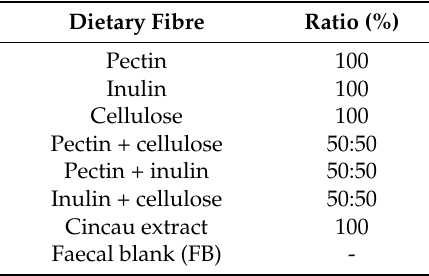
Table 2. Type of dietary fibre and combinations used for batch in vitro fermentation. Dietary